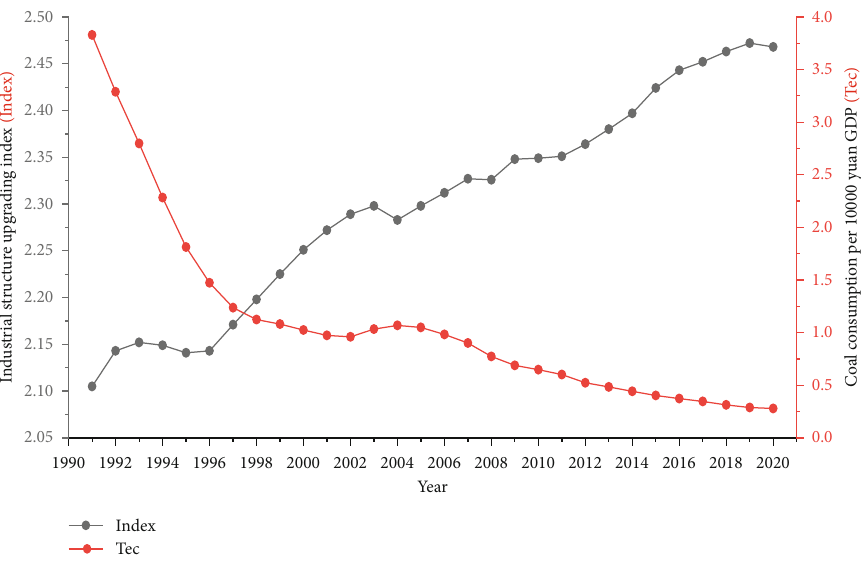
Figure 2: Comparison between China ’ s coal consumption and industrial structure index. Table 1: Granger causality test between Tec and Index.